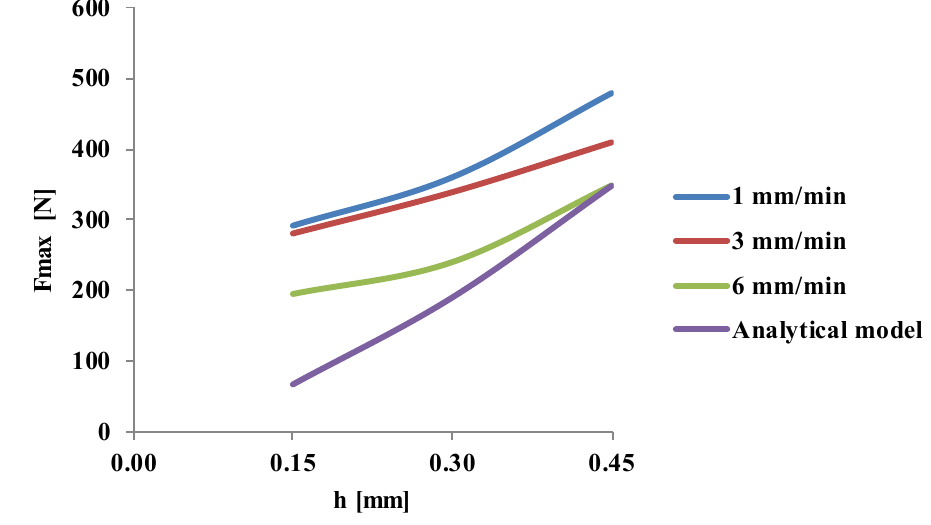
Figure 3. Delamination onset test results as a function of uncut thickness ( h ) and test speed—experimental values and analytical model Equation